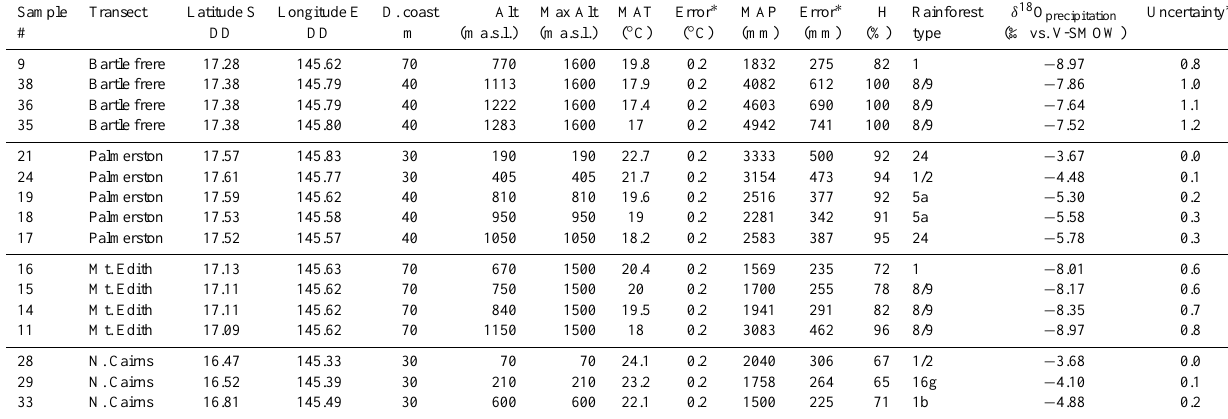
Table 1. Location of the sampled sites and associated climate parameters provided by the ANUCLIM software (D. coast: distance from the coast; Alt: altitude; Max Alt: mean maximum altitude crossed by air masses; MAT: mean annual temperature; MAP: mean annual precipitation; H: relative humidity). Rainforest types from Tracey (1982). δ 18 O precipitation values are estimated from Eqs. (7) and (8) slightly modified after Bowen and Wilkinson (2002).